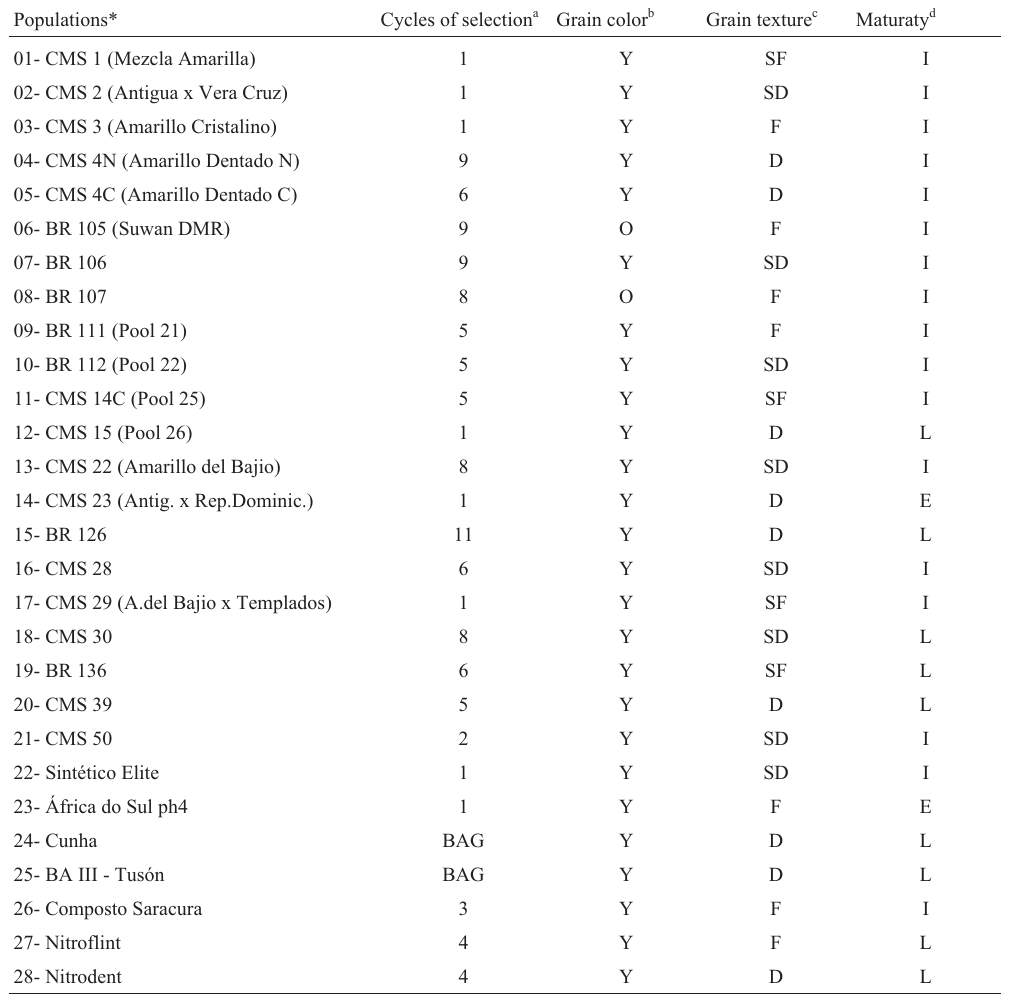
Table I. Characteristics of the 28 parental populations from the maize breeding program of Embrapa Maize and Sorghum Research Center.